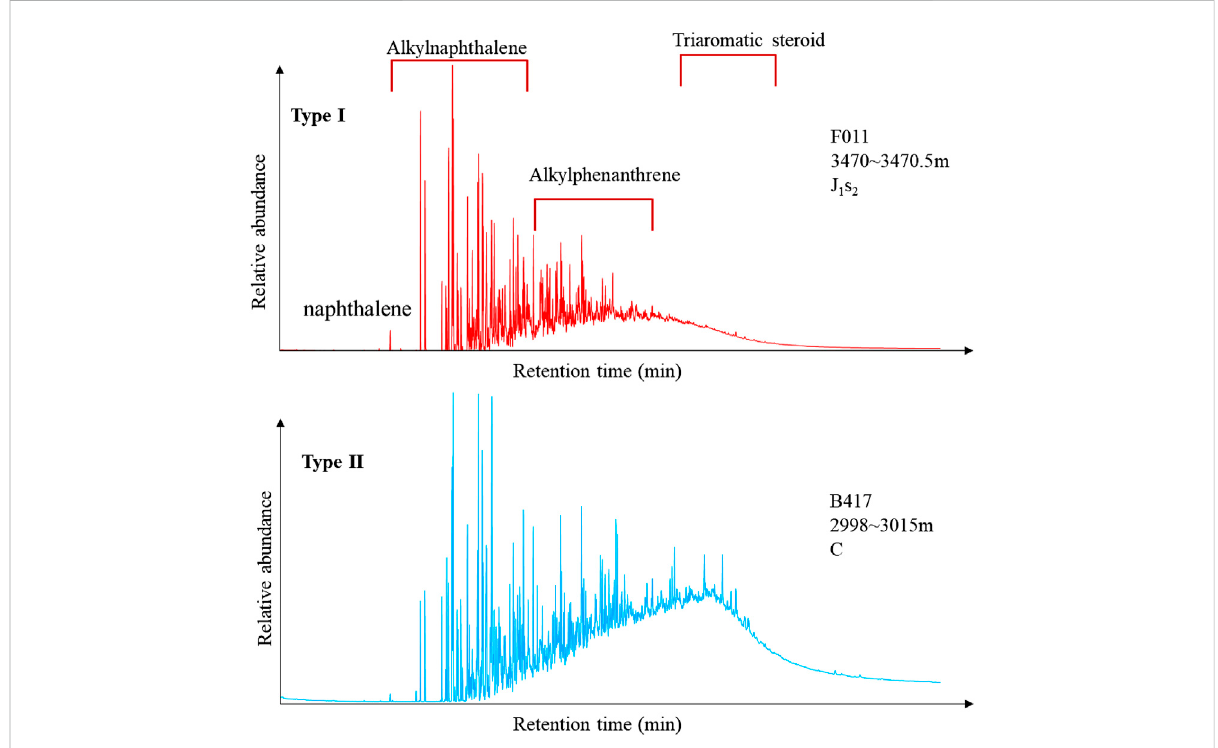
FIGURE 5 Total ion chromatograms (TIC) of aromatic fractions in crude oil from the East Fukang